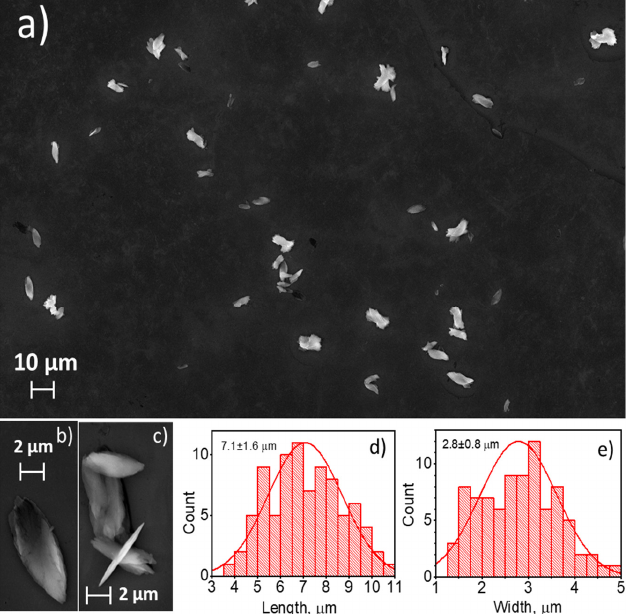
Figure 2. SEM images of Sample 2 (panels a–c ). Particle size distribution (length and width) is shown in panels ( d ) and ( e ). The particles have the shape of the elliptic plates with ratio length:width:height of about 13:5:1. The average length and width were found to be equal to 7.1 ± 1.6 and 2.8 ± 0.8 μ m, respectively.